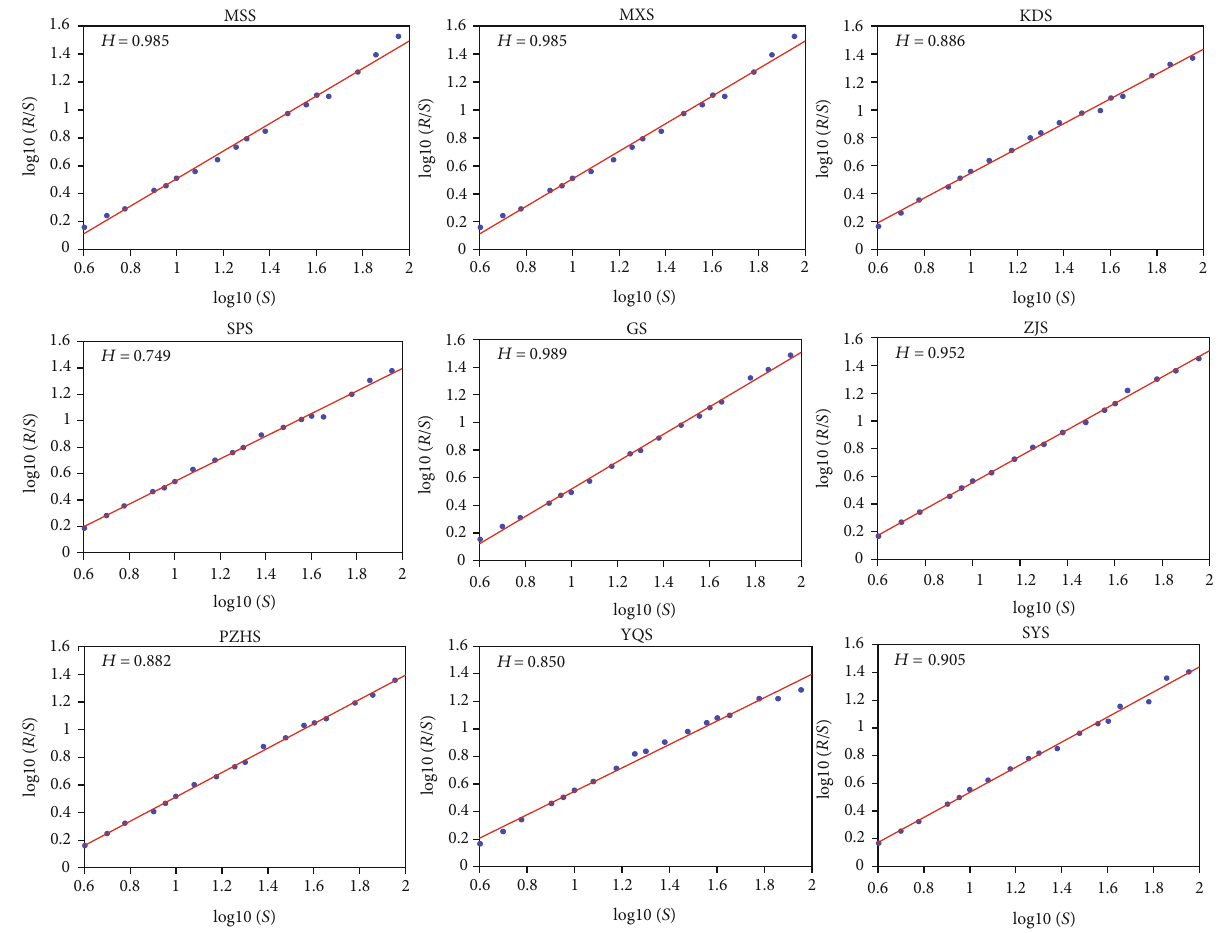
Figure 4: The H estimate of Rn time series recorded at di ff erent monitoring stations. The recorded Rn data inherent to the characteristics of long memory trend such as persistency ð 0 : 5 ≤ H ≤ 1 Þ . The H values lying within the range of 0.749 to 0.989 and show a trend continuation rather than trend reversion or white noise. In the case of white noise, the time series is no more favourable for retrospective analysis of earthquake forecasting